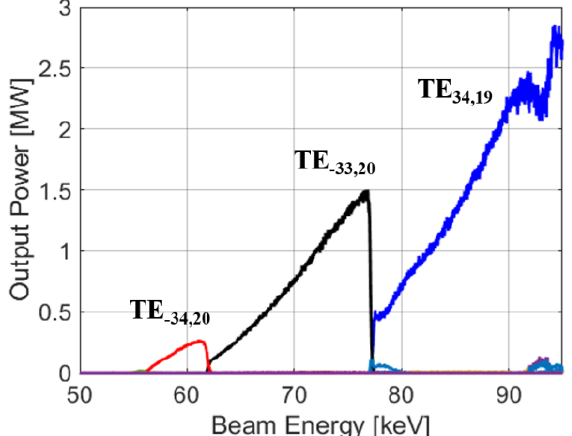
Fig. 3. Realistic start-up scenario with existing coaxial cavity at 6. 86 T and I beam = 75 A without non-linear uptaper using the magnetic field profile proposal from the new SC magnet and the gun parameters from the new coaxial MIG.